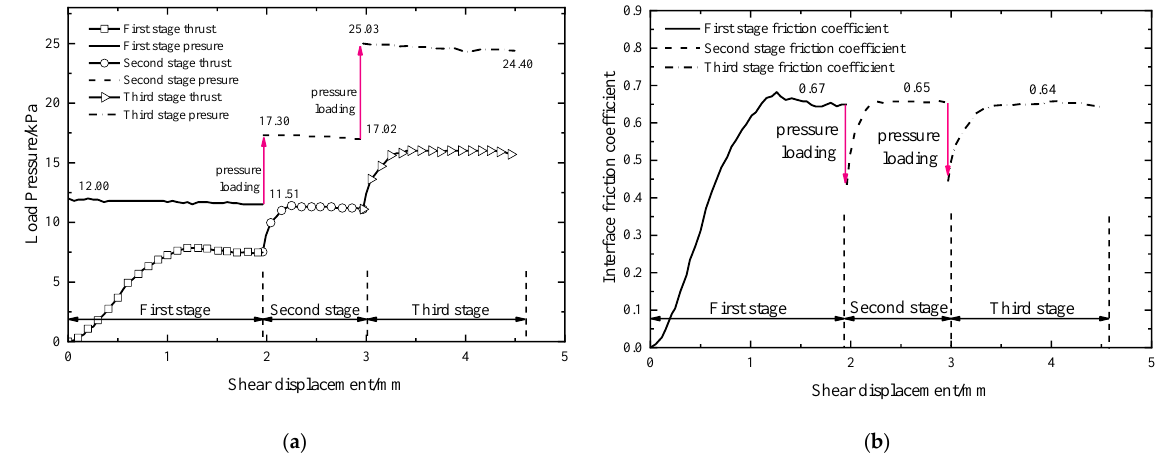
Figure 13. Interface shear test results of the T C28d group: ( a ) Load displacement curve of the T C28d group and ( b ) Friction coefficient displacement curve of the T C28d group.